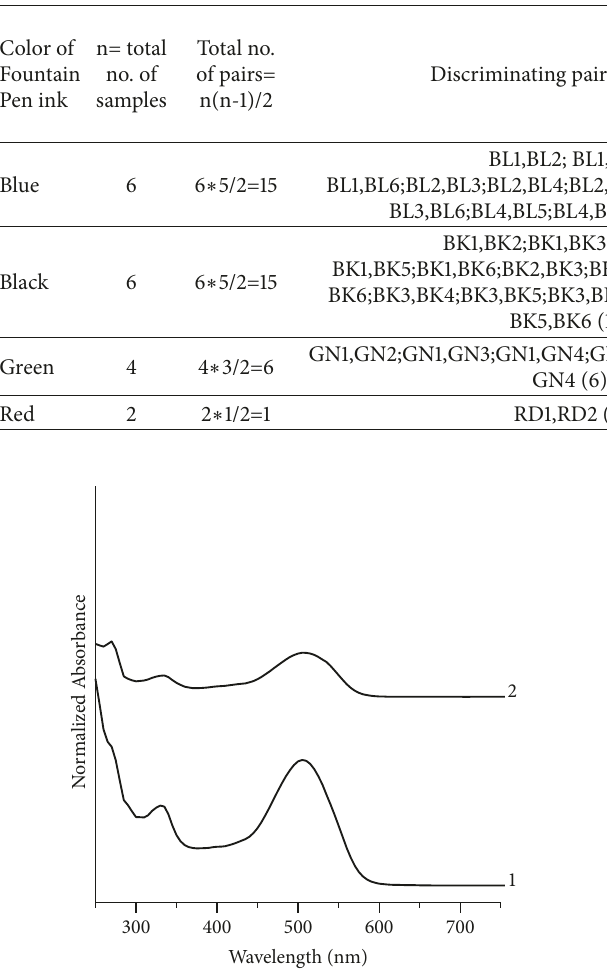
Figure 4: Normalized UV/Visible absorption spectra for red foun- tain pen inks 1 and 2 represent RD1 and RD2,